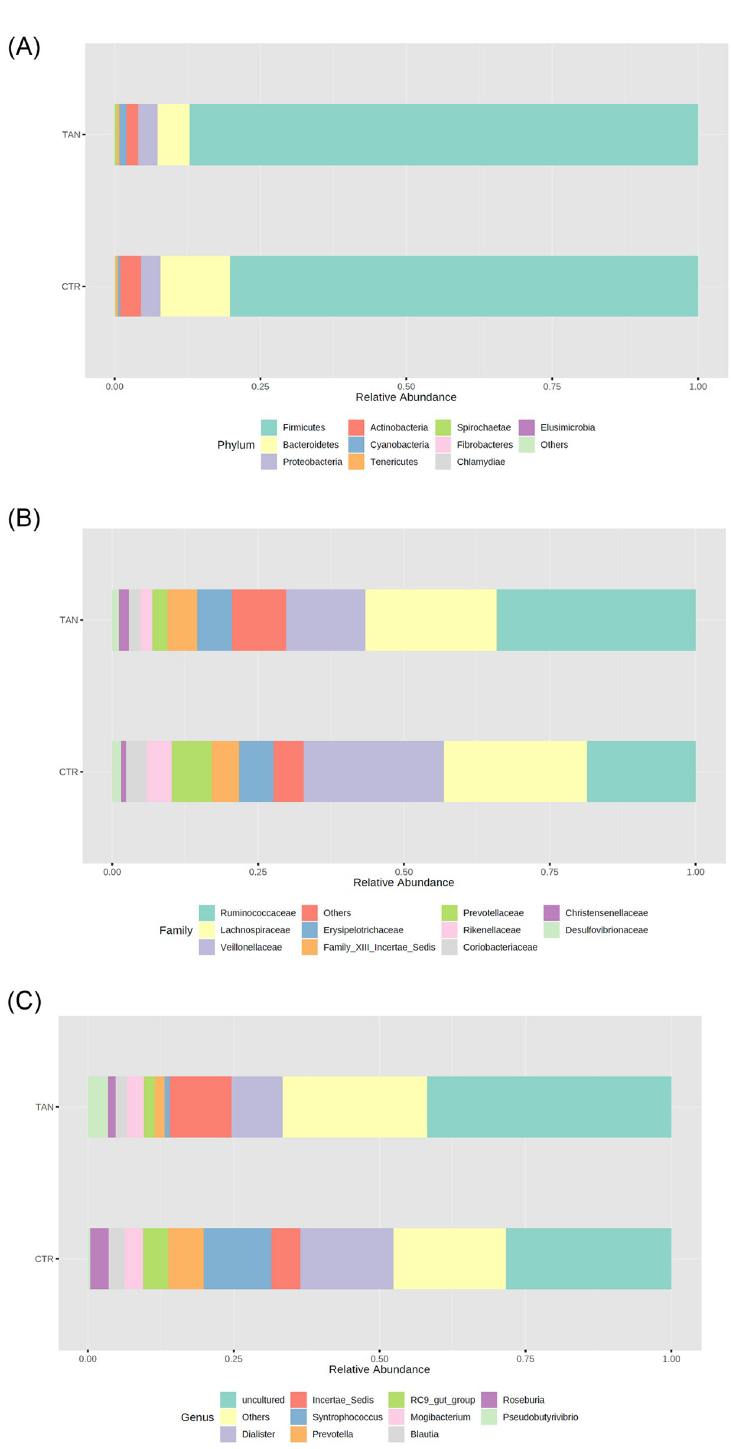
Fig 2. Relative abundances of phyla (A), families (B), and genera (C) observed in the tannin-supplemented group (TAN) compared with those of the control group (CTR). Only the top taxa are represented in the graphs.